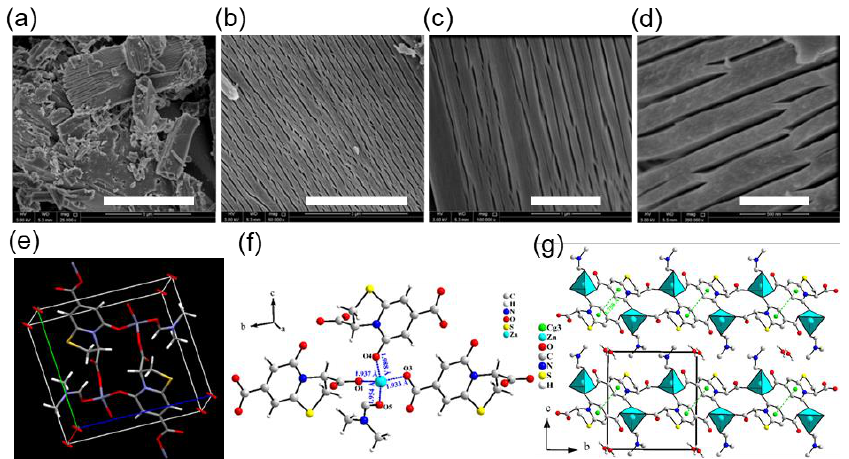
Figure 2. SEM images of QUF-001 at different magnifications, namely ( a ) 25,000×, ( b ) 50,000×, ( c ) 100,000× and ( d ) 200,000×, with scale bars indicating 5 microns, 3 microns, 1 micron and 500 nm, respectively. ( e ) Scheme showing the Zn(II) coordination in the QUF-001 unit cell and ( f ) the coordination sphere of the zinc cation. ( g ) View of the layered structure of QUF-001 along the a -axis. The green dashed lines correspond to π – π interactions between the six-membered rings forming TPDCA linkers. Cg 3 is the centroid of the six-membered ring.